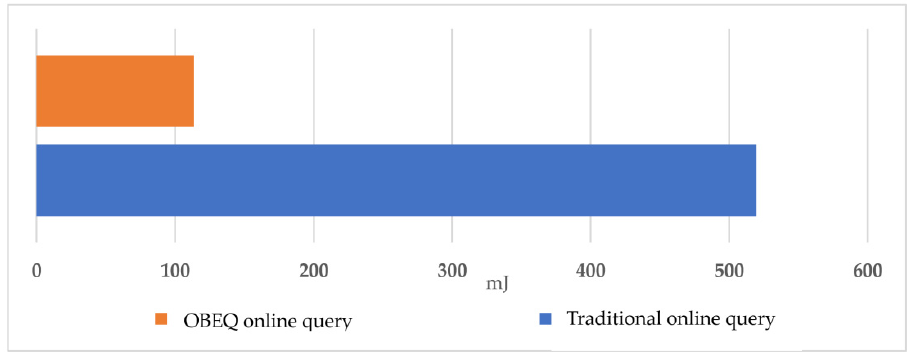
Figure 16. The power consumption of AVG aggregation.